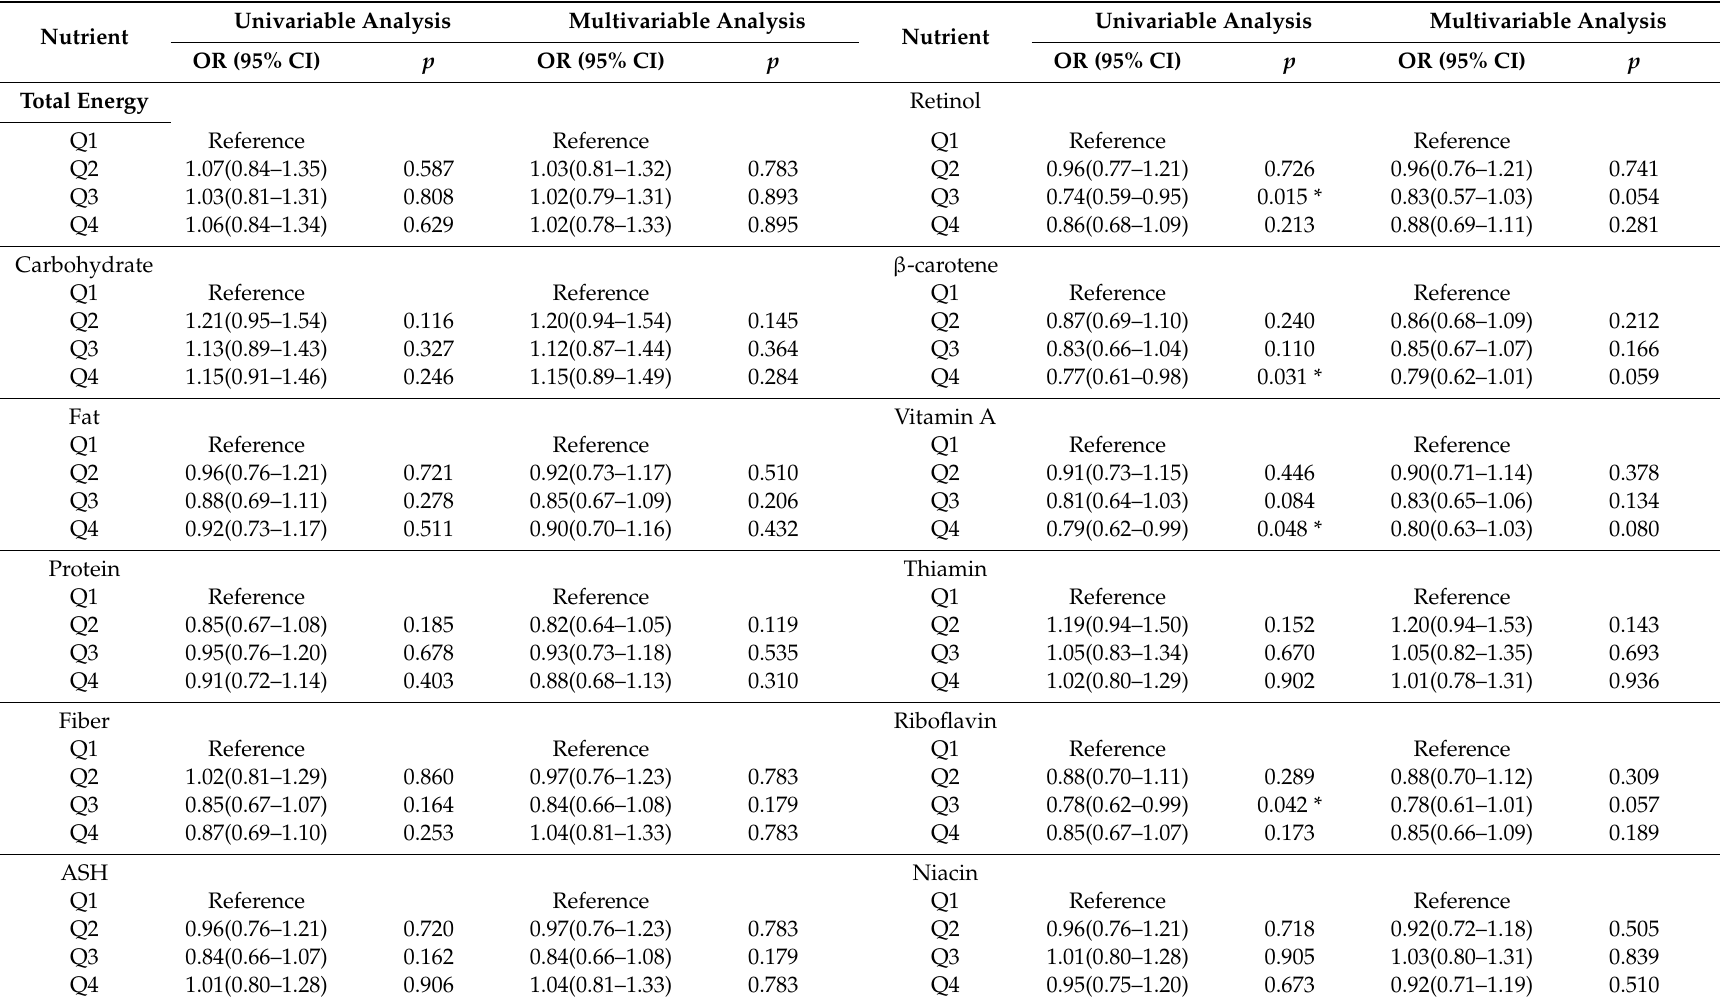
Table 4. Odds ratios of nutritional factors for unilateral hearing